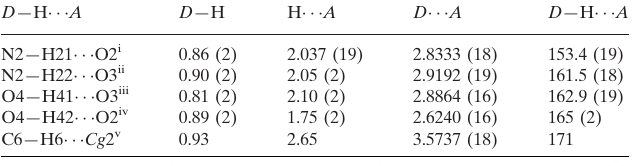
Hydrogen-bond geometry (A˚ , (cid:2) ). Cg 2 is the centroid of the N1/C9–C13